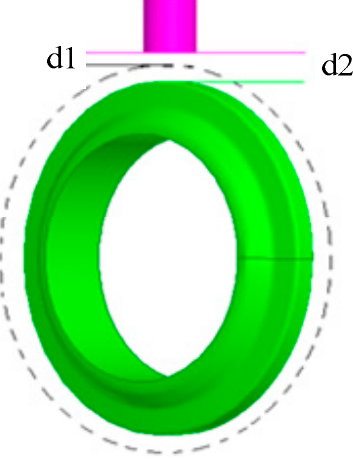
Figure 12. Principle of wear measurement.